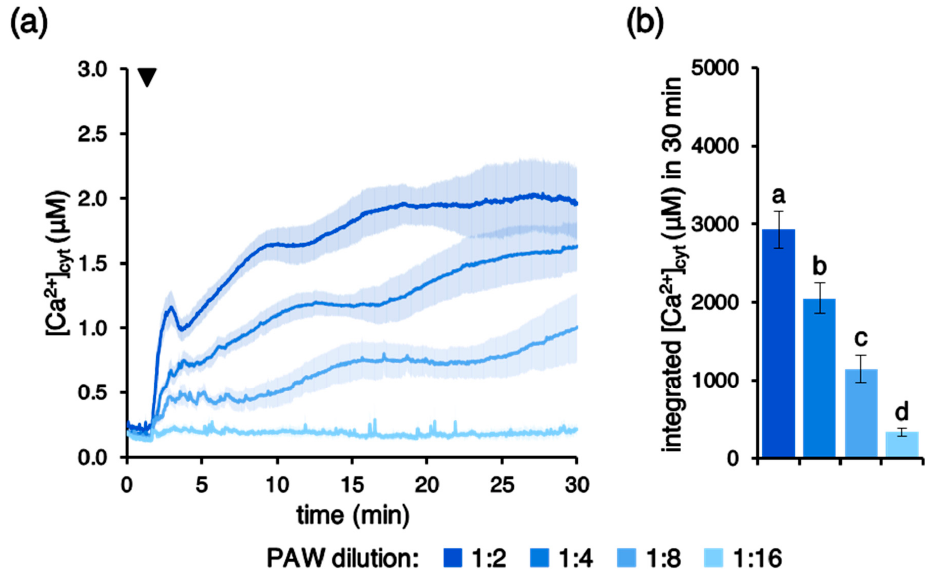
Figure 3. Concentration dependence of PAW-induced [Ca 2+ ] cyt increases. Ca 2+ measurement assays were conducted in aequorin-expressing Arabidopsis seedlings. Seedlings were challenged with progressive dilutions of PAW (lighter colours indicate more diluted PAWs) generated by exposing deionized H 2 O to cold plasma for 5 min at 900 W torch #1 power. ( a ) Data are the means (solid lines) ± SE (shading) of six seedlings derived from three independent growth replicates. The arrowhead indicates the time of stimulus application (at 100 s); ( b ) statistical analyses of integrated [Ca 2+ ] cyt dynamics over 30 min are shown. Bars labelled with different letters differ significantly ( p < 0.05, Student’s t test).